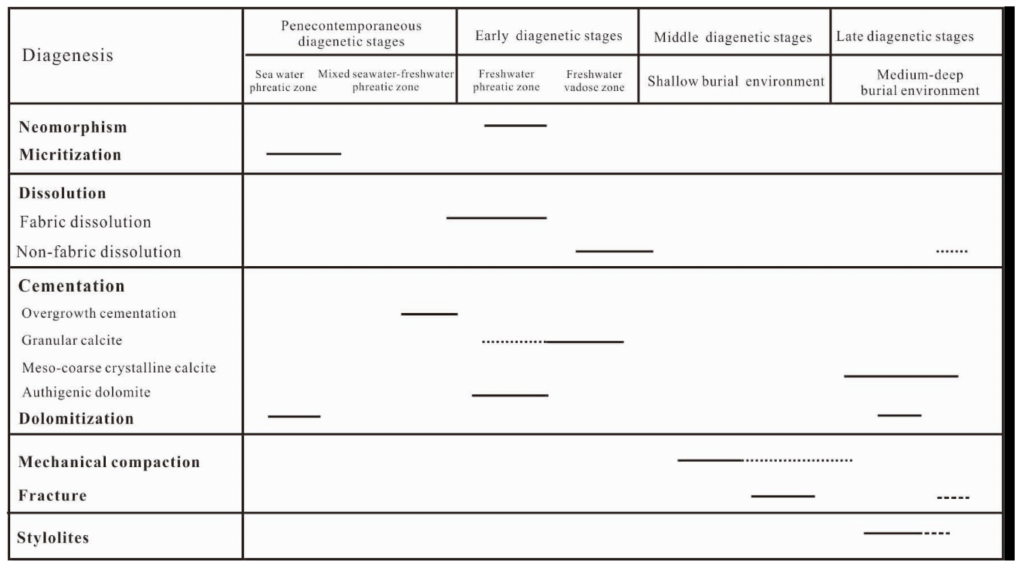
Figure 4. The paragenesis of the limestones from the Mi4 member in the Ah Oilfield.